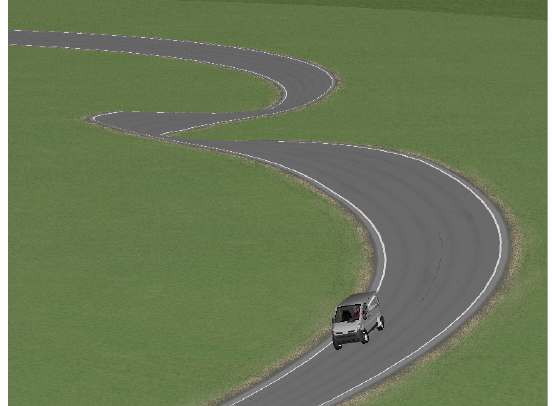
Figure 16. Global view for Test 3.